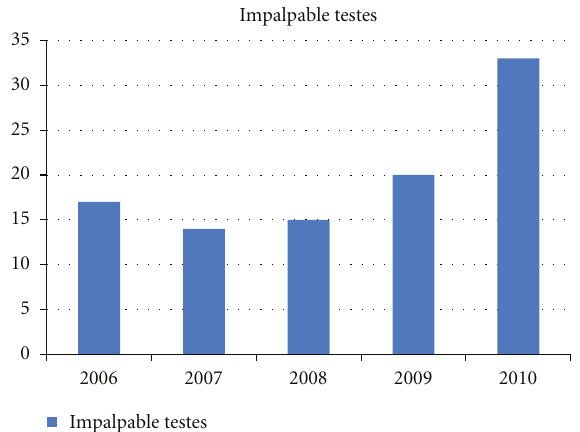
Figure 1: Numbers of impalpable undescended testes explored laparoscopically per year from January 2006 to December 2010.